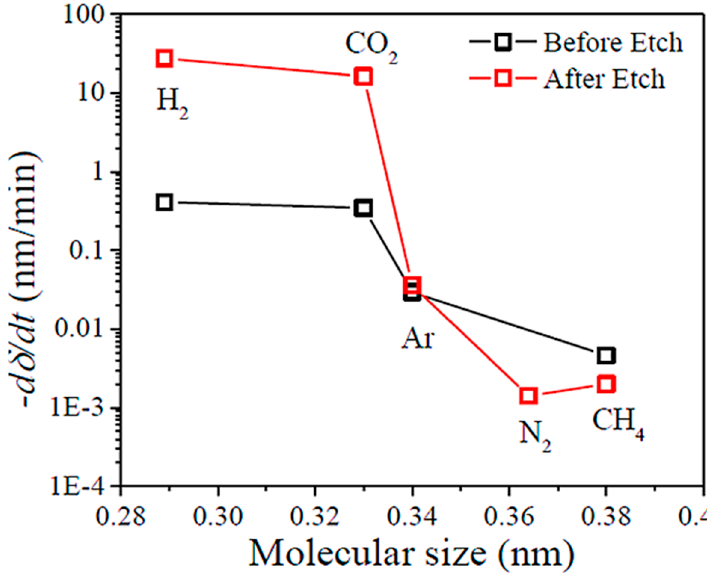
Figure 5. Comparing leak rates between pristine and porous graphene membranes [94]. Reproduced with permission from Nature.